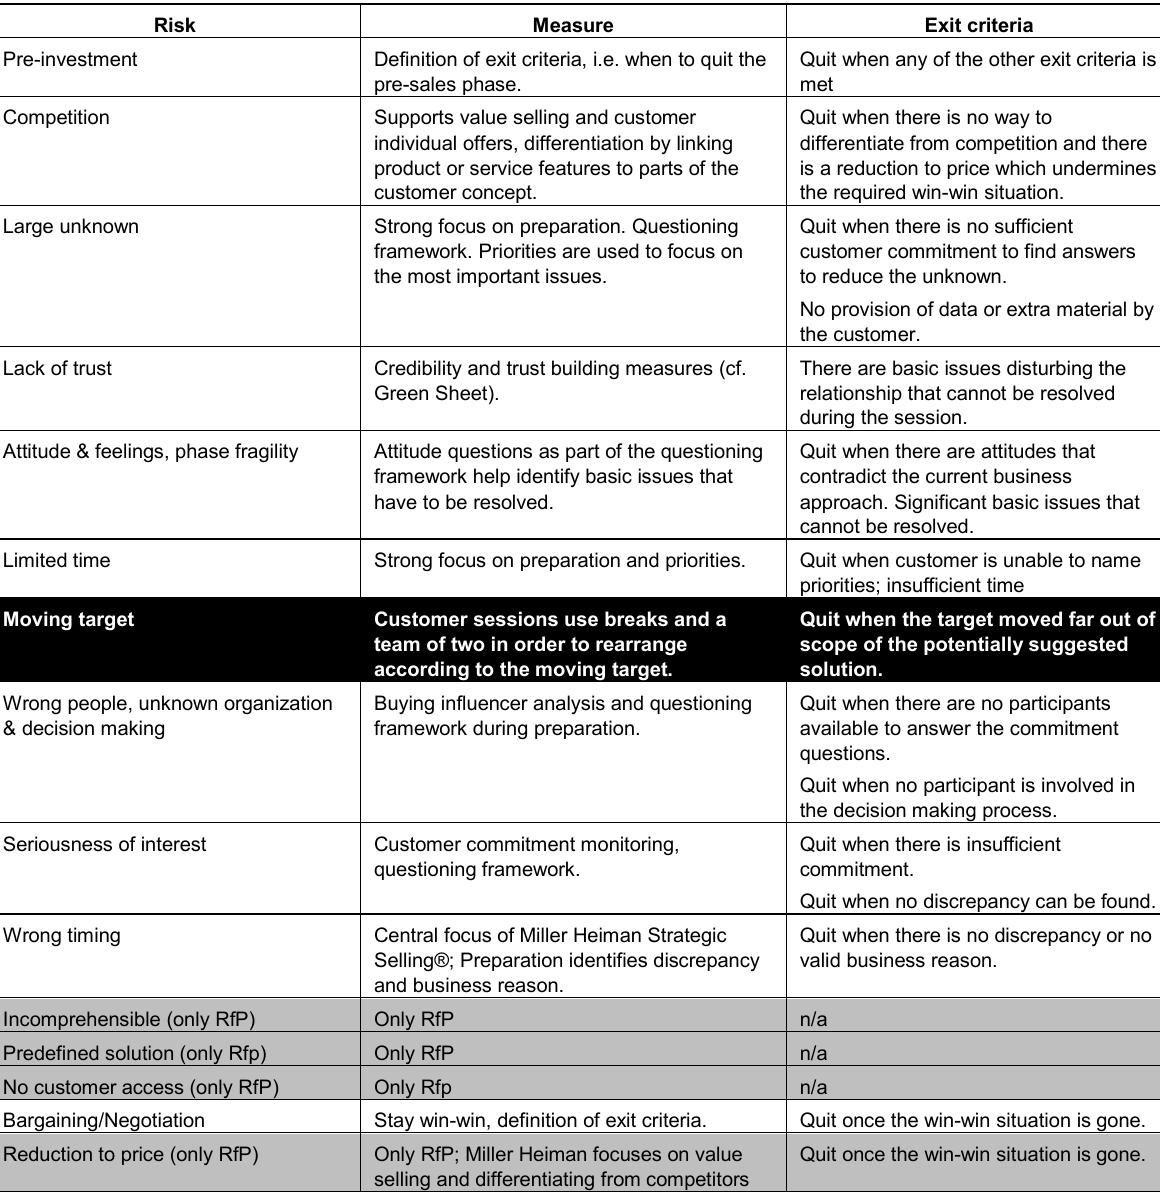
Table 3. Overview of risks, measures and exit